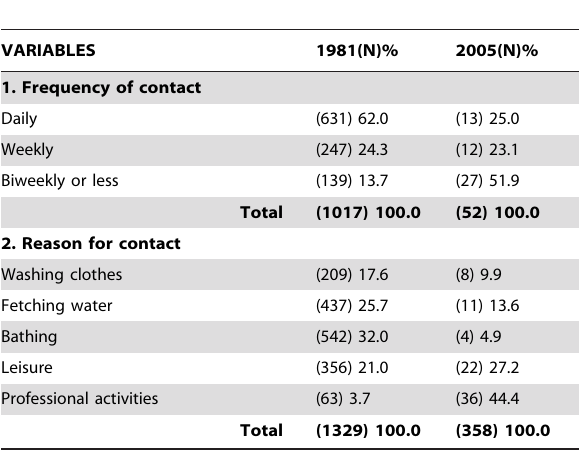
Table 4. Report on contact with natural waters in Comercinho/MG, Brazil